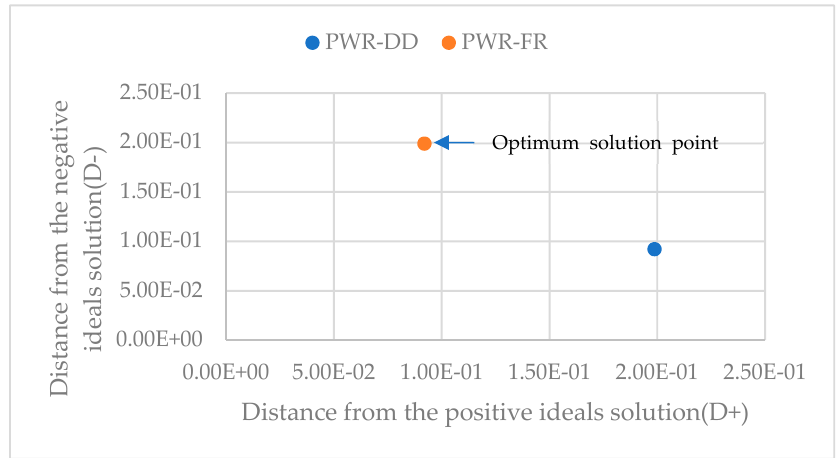
Figure 6. TOPSIS evaluation results.